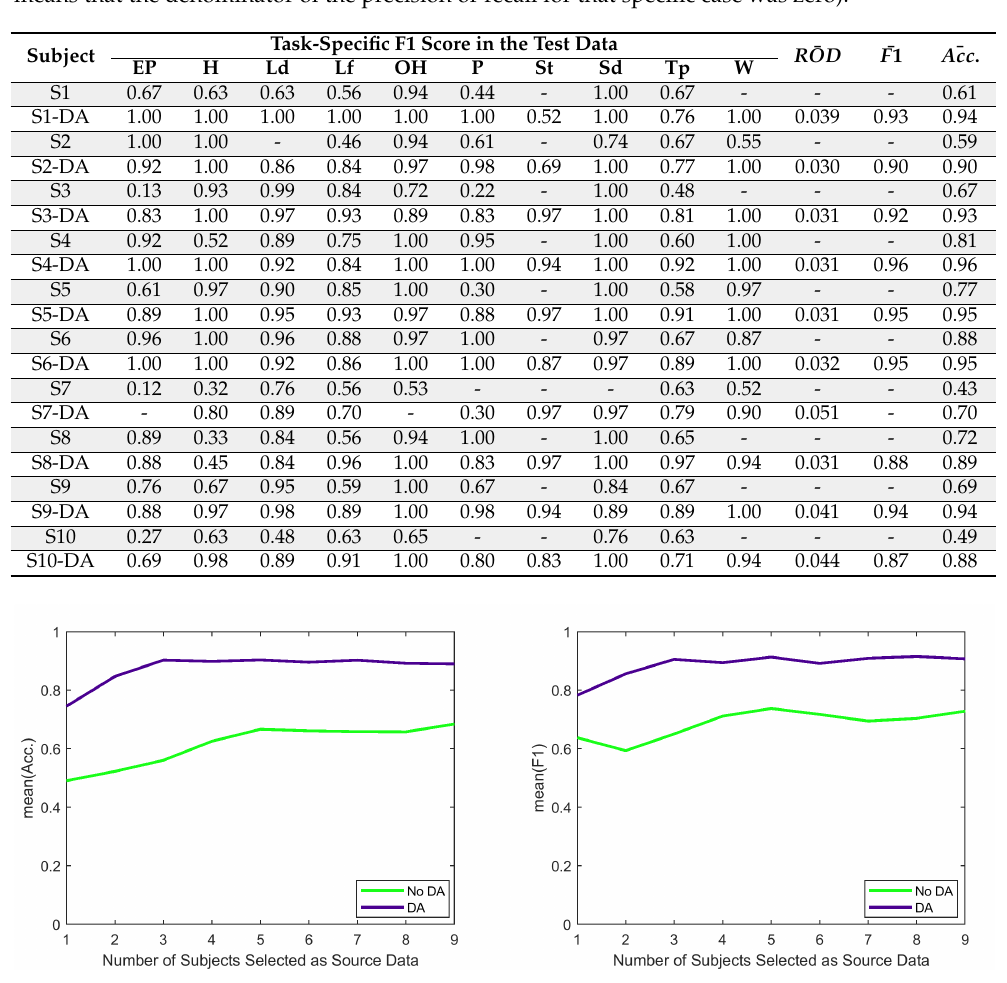
Figure 6. Impact of k on overall accuracy and overall F1 score in cross-sensor and cross-subject classification Table 7. The number of excluded cases to obtain overall F1 score for cross-sensor and cross-subject